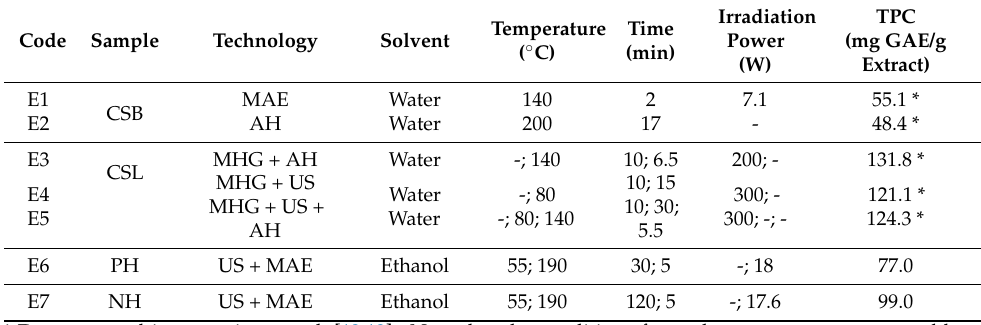
Figure 1 . General scheme of gluten-free hydrogel production. T = temperature; t = time; CSB = Camellia sinensis branches; CSL = Camellia sinensis leaves; PH and NH = industrial hops; MAE = microwave-assisted extraction; AH = autohydrolysis); MHG = microwave hydrodiffusion and gravity; US = ultrasounds. Table 1. The selected processing conditions for used antioxidant extracts from Camellia sinensis agricultural wastes ( Camellia sinensis branches (CSB) and Camellia sinensis leaves (CSL)) and indus- trial hops (PH and NH).